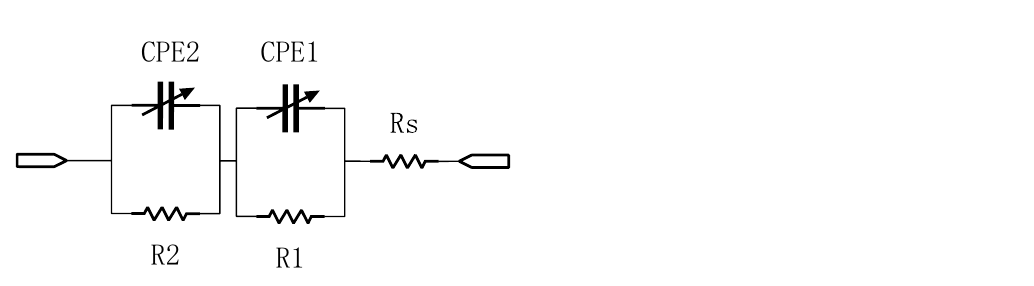
(b) The phase of the impedance of the sample and the MFIA results under different time. Figure 7. The comparison between the results from the FDICS and the MFIA when testing on the corrosion cell.